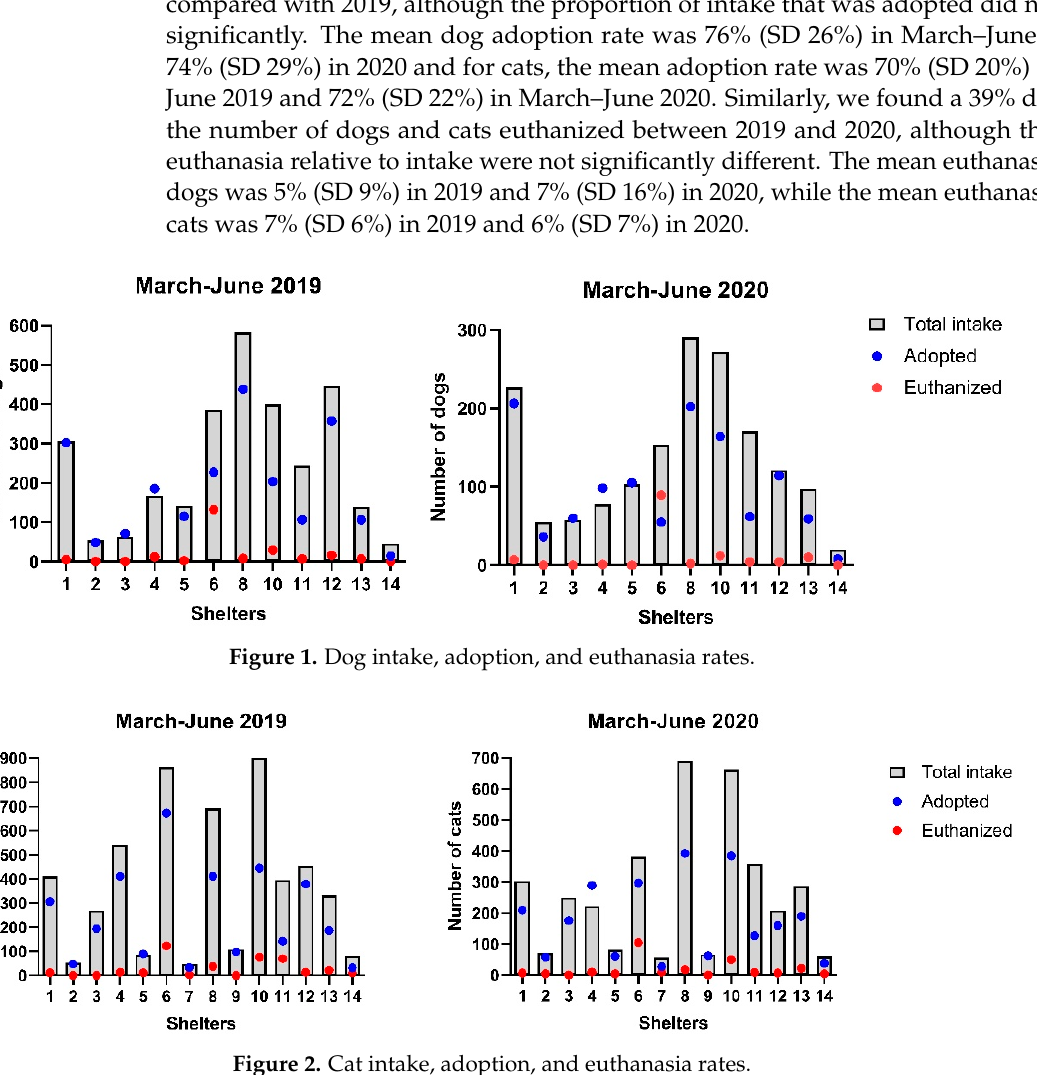
Table 2. Intake and outcome data for March–June 2019 and 2020.